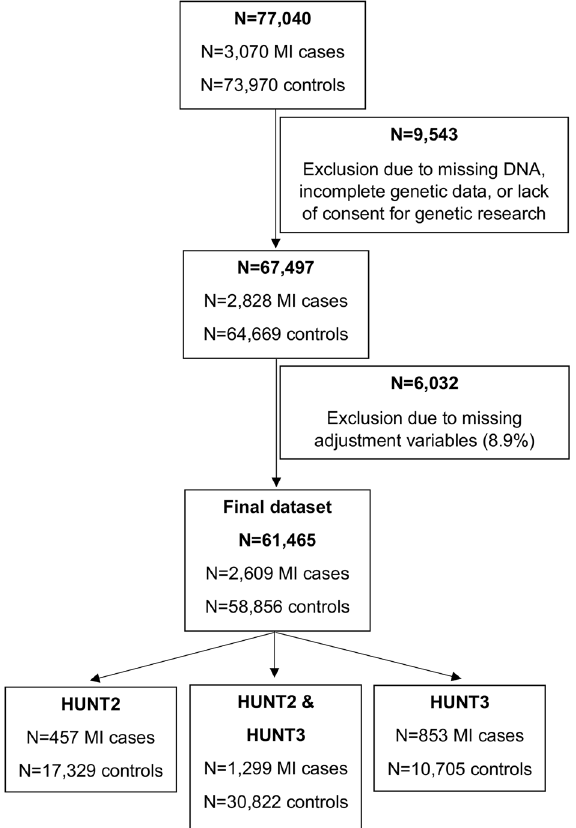
Figure 1. Inclusion and exclusion of study participants. Abbreviation: MI: myocardial